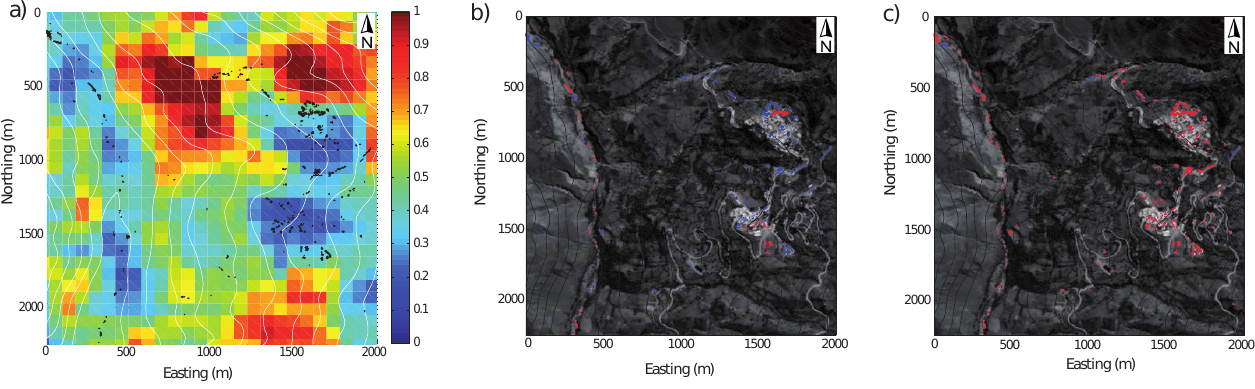
Figure 3. Different steps of the detection of large scale changes. First, the image of correlation C ( x, y ) is calculated ( a ). We note that low correlation corresponds to area with a high density of changes (black points). ( b ) Then, the objects situated on low slopes are detected (red points). ( c ) The area is finally expanded to connected points with similar or lower correlation than the objects detected in step ( b ). The remaining blue points are candidates for being